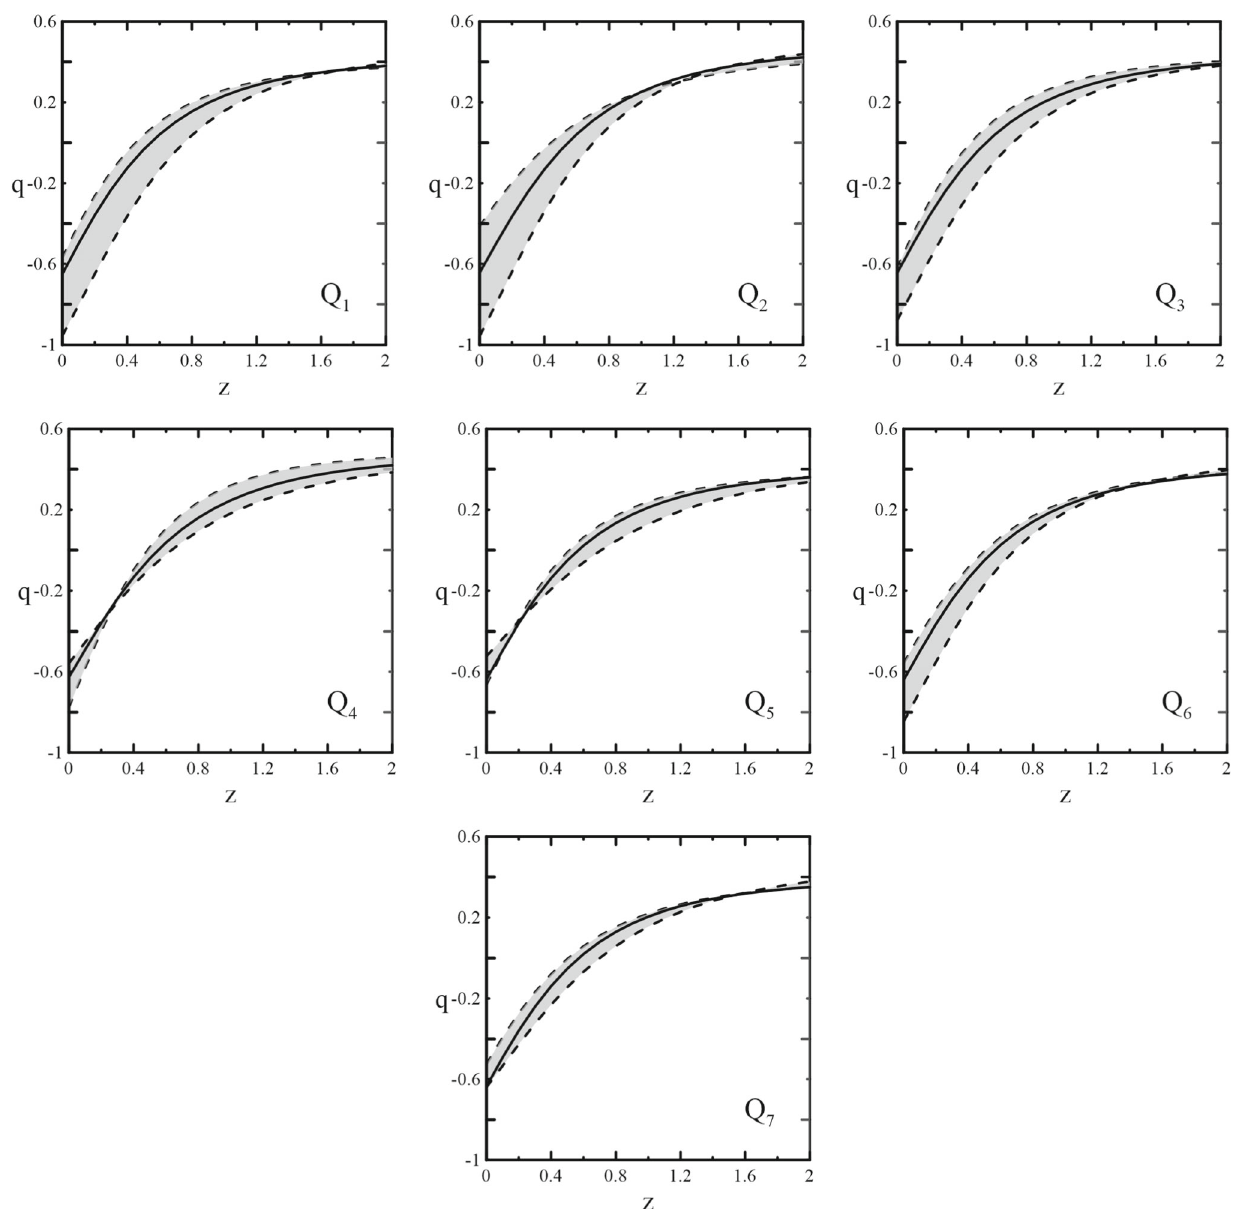
Fig. 2 The evolution of the deceleration parameter in terms of redshift forEHRDEmodel(Eqs.(21)and(22))withthecorresponding1 σ inter- val level according to the best fitted value listed in Tables 4 and 5 and